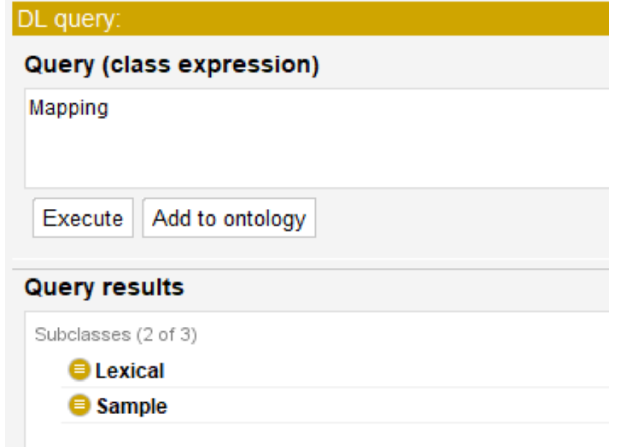
Figure 5. Execution of the DL mapping query using the Protégé editor and corresponding result, execution time was 25 ms.